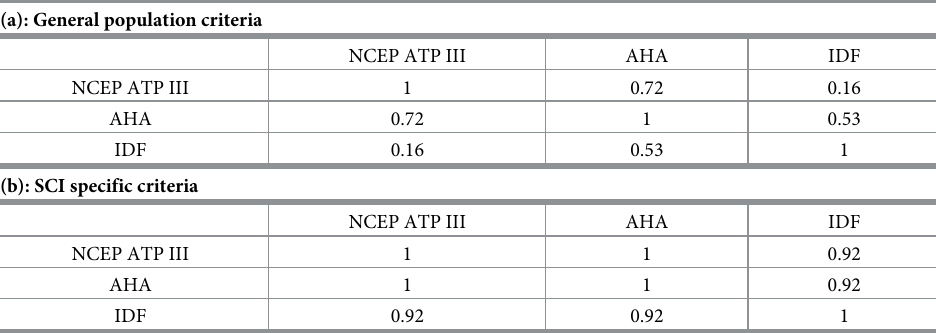
Table 4. Cohen’s kappa ( κ ) agreement for three MetS definitions using different